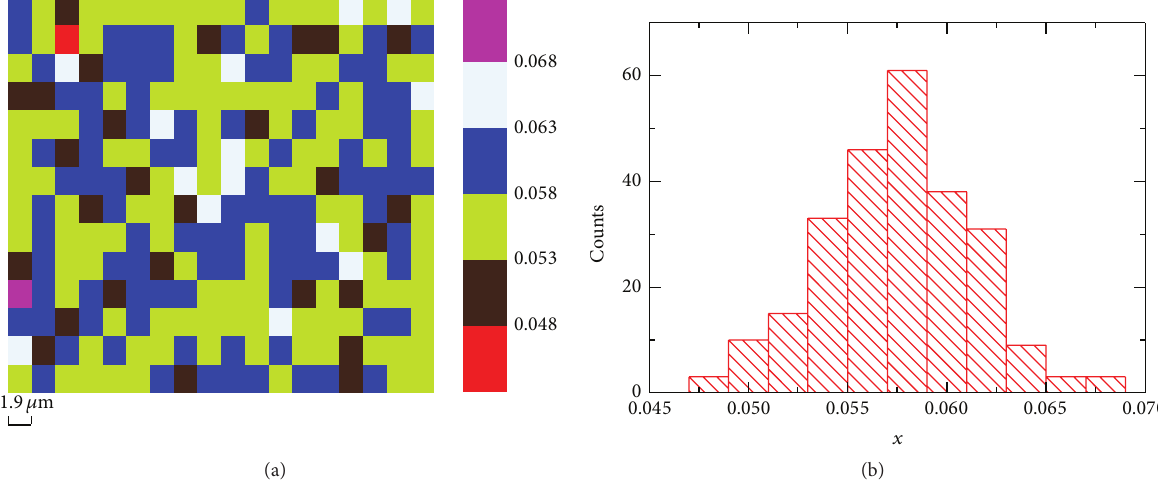
Figure 1: (a) The mapping image (color online) of Ni concentration throughout an area of 38 𝜇 m × 28 𝜇 m based on the EDS quantitative results. (b) The chart of the Ni distributions summarized from same data as